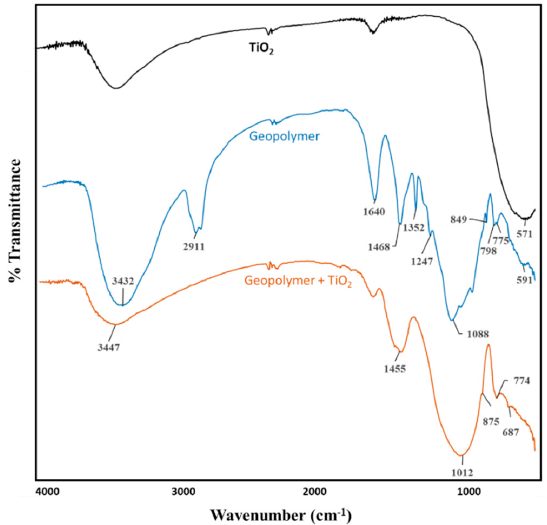
Figure 5. Schematic diagram of the hydrolysis–condensation reaction of titanium isopropoxide ( top ) in solution and ( bottom ) on the GP surface.